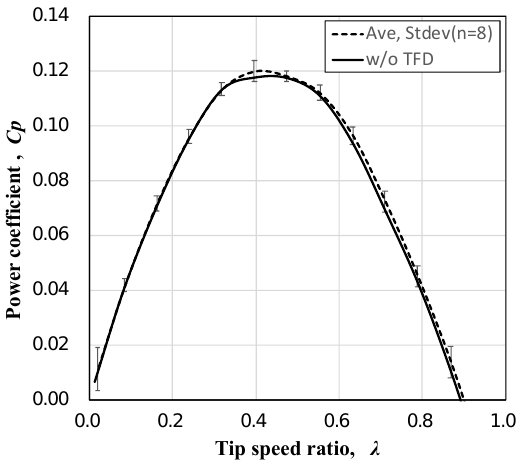
Figure 7. Averaged performance curve with standard deviation bars of bare cross-flow wind turbine (n = 8, without three flow deflectors (TFD)) compared with the performance curve of same wind turbine for this study (without TFD).